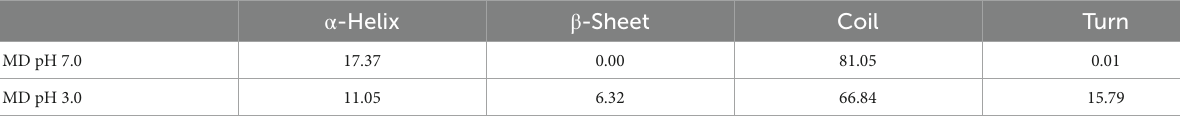
Table 1 The secondary structure content of κ -casein at physiological pH